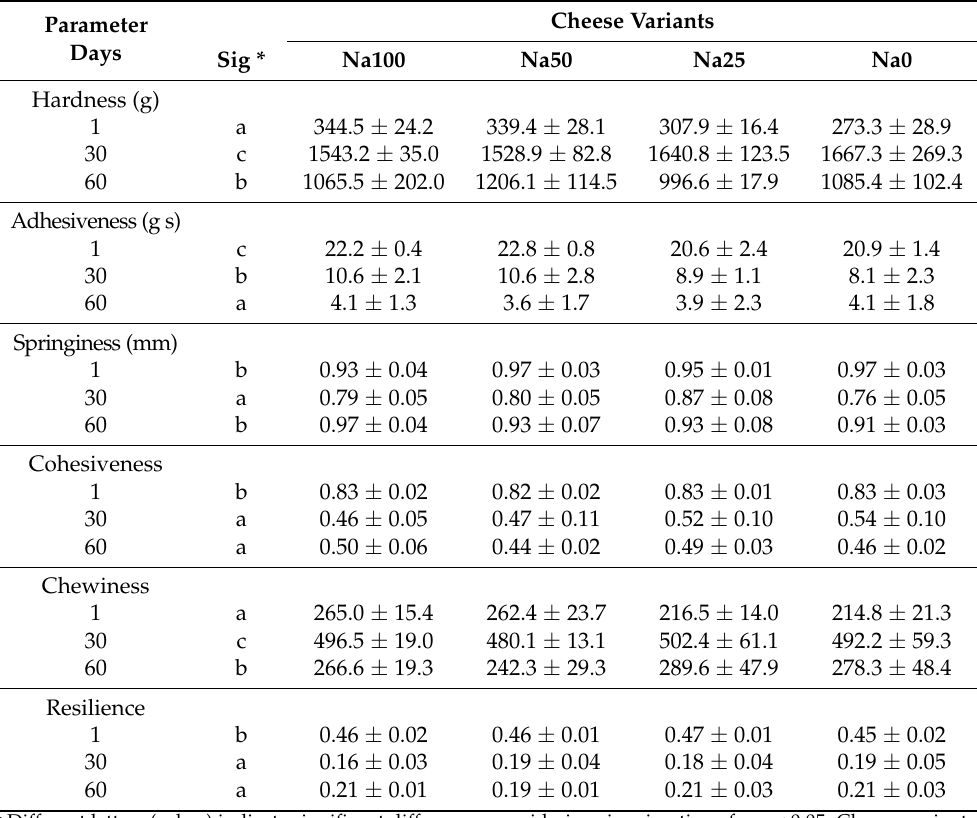
Table 4. Textural parameter of white brined cheese manufactured with different ratios of NaCl and KCl after 1, 30 and 60 days of